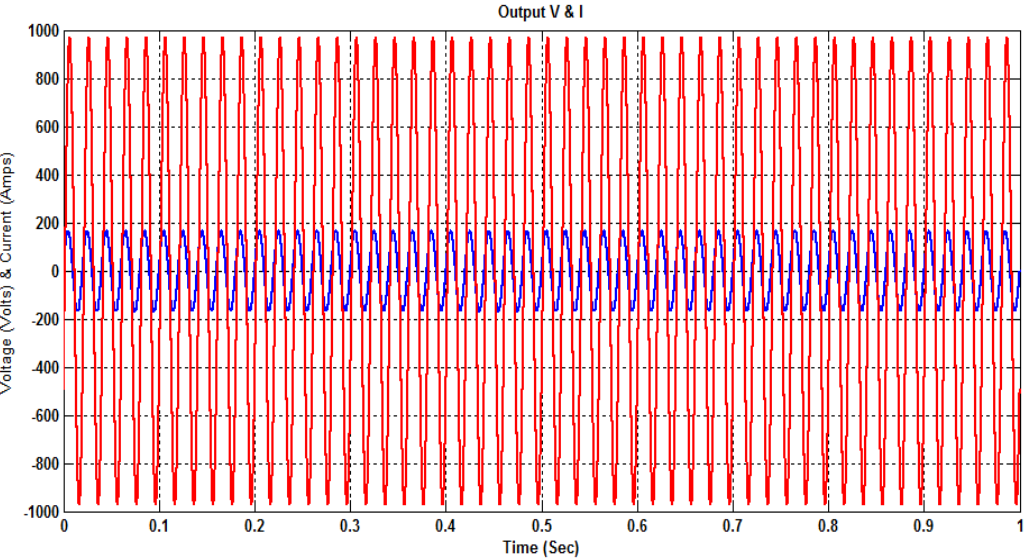
Figure 10. Measurements of the real and reactive power on the load side.